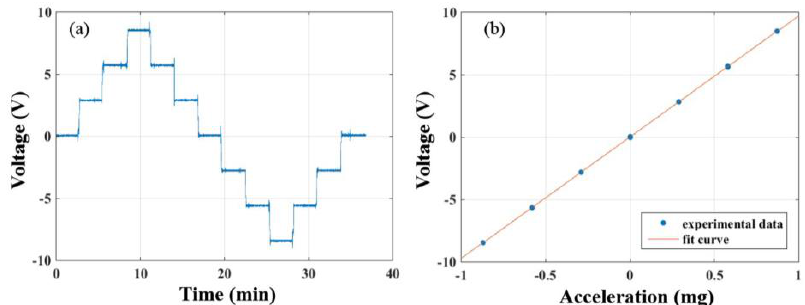
Figure 9. The results of calibration of accelerometer’s scale factor ( a ) Calibration curve with the step about 0.29 mg; ( b ) Result of linear fit with the scale factor 𝐾 = (9725 ± 11) V/g and the nonlinearity of about 0.1% .